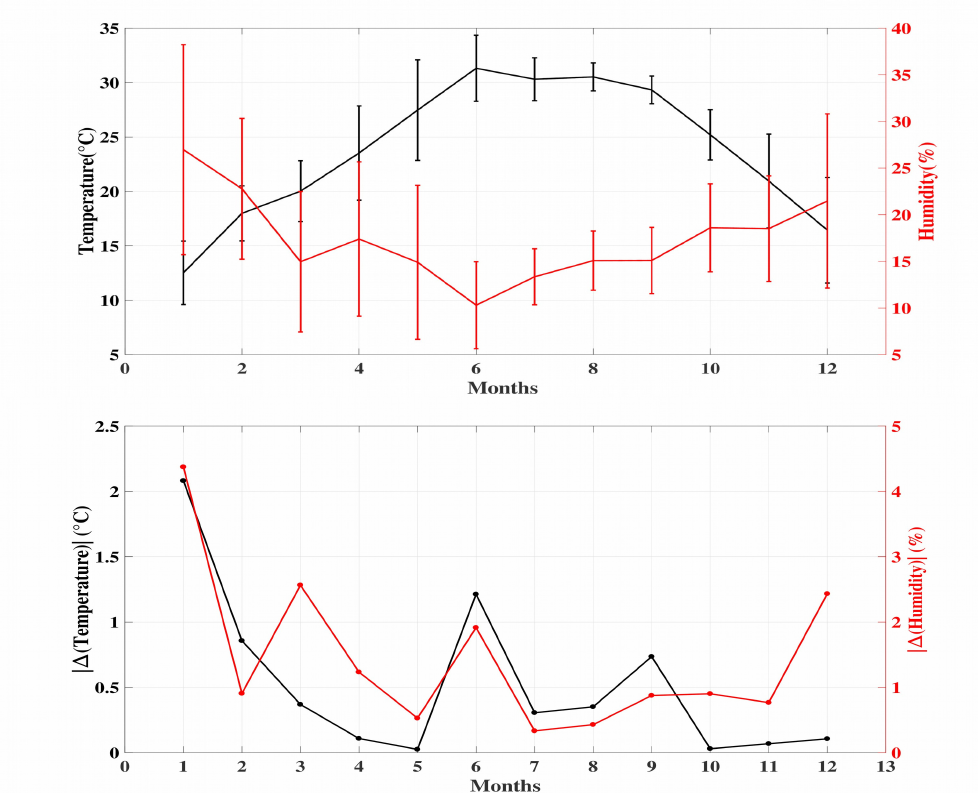
Figure 9. Top plot: Monthly average between 2005 and 2011 of the temperature (black line) and humidity (red line) recorded at the ground level at Tamanrasset. Bottom plot: The Laplacian of the monthly average temperature (black line) and humidity (red line) showing their local